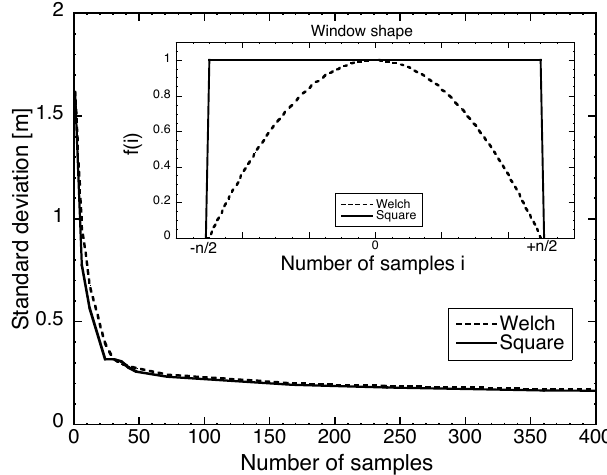
Fig. 4. Standard deviation of the NBRef data as a function of num- ber of samples ( n ) for a square (boxcar) and Welch window. Note that with a sample time of one hour the number of samples is equiva- lent to hours. In the inset the shapes of the Welch and square weigh- ing functions ( f i ) are